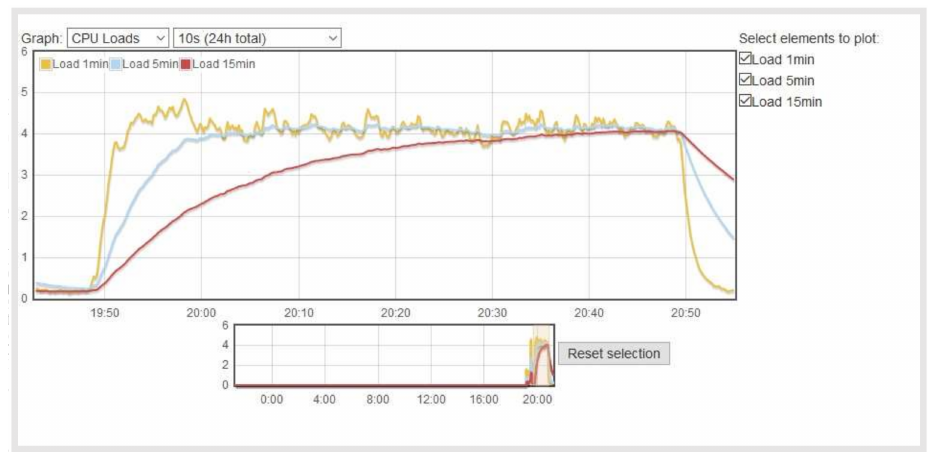
Figure 10. Raspberry Pi CPU load with the Python